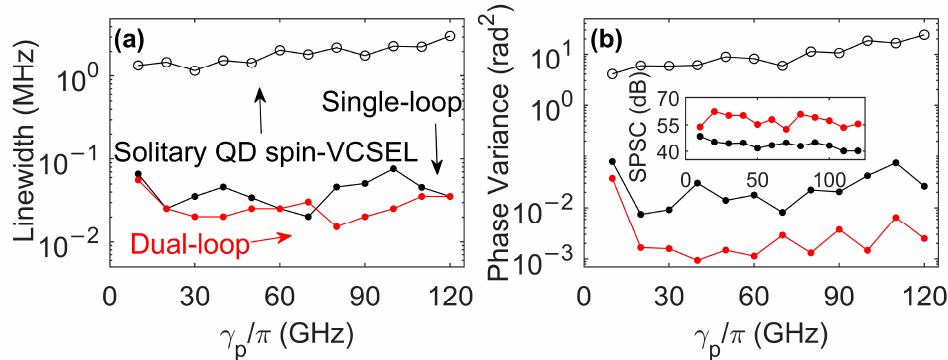
Figure 9. ( a ) Microwave linewidth and ( b ) phase noise variance as a function of P1 oscillation frequencies, where the optically pumped QD spin-VCSEL is subject to no feedback (hollow circles), single-loop feedback (black dots), and dual-loop feedback (red dots). These dots represent relatively optimized results with varying feedback parameters.